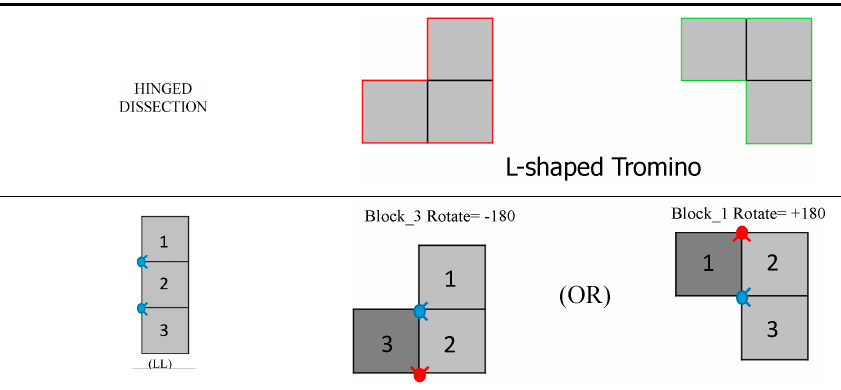
Table 1. LL hinged points of hTromo robot. LL: Left Left.